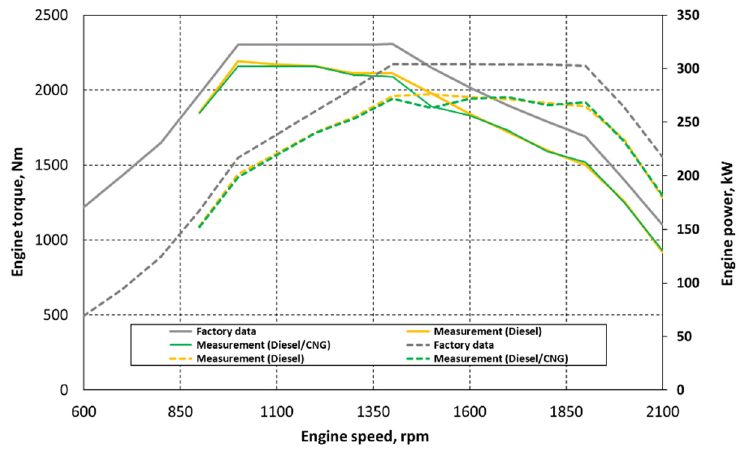
Figure 2. External characteristics of the engine: solid line—torque, dashed line—power. Table 2. Comparison of the values of the torque and the useful power used in the traction calcula- tions of a set of vehicles.